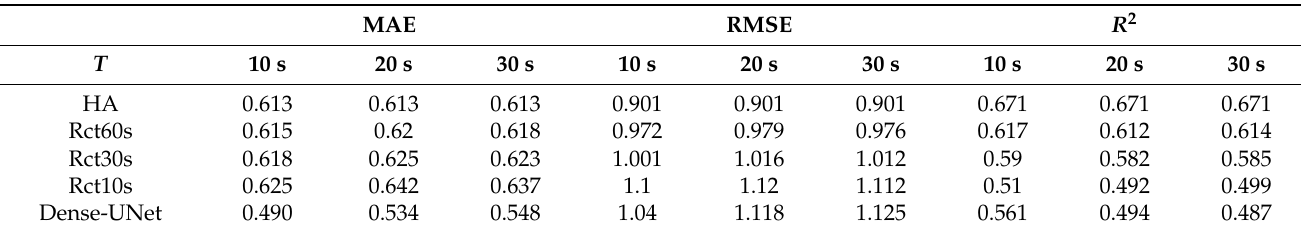
Table 2. Experimental results according to time interval T